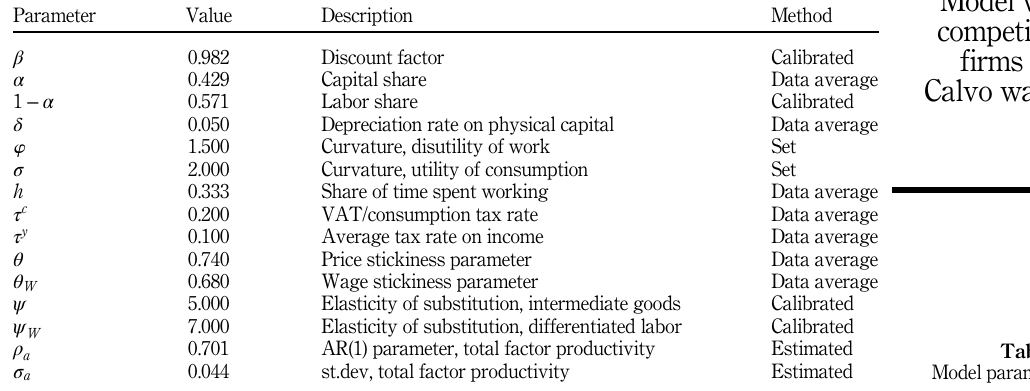
Table 1. Model parameters